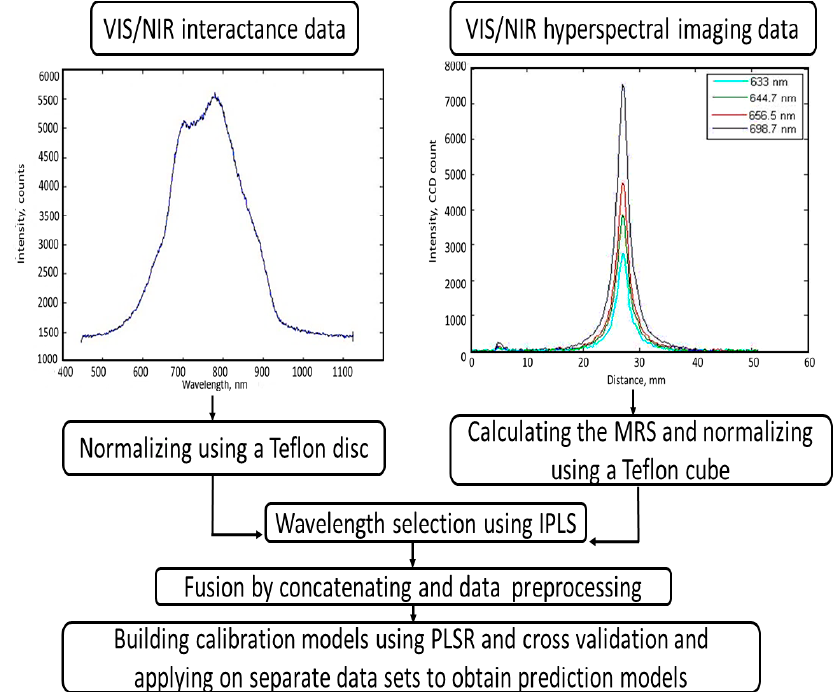
Figure 3. Flow chart of acquiring data from VIS/NIR spectroscopic and VIS/NIR hyperspectral imaging systems, wavelength selection, preprocessing, and building regression models of leaf primordia count for FL1879 and R.Norkotah potato cultivars.